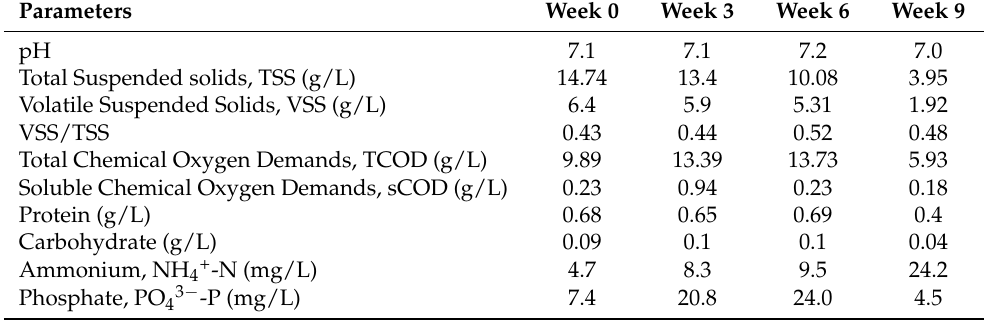
Table 3. Waste-activated sludge features.